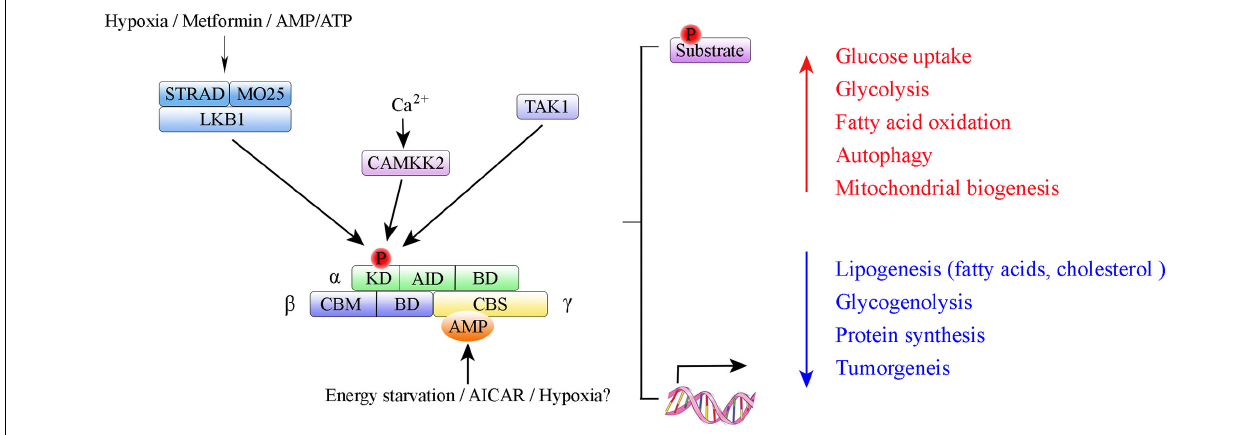
FIGURE 1 | Summary of AMP-activated protein kinase (AMPK) structure and activation. Domain structure of AMPK trimer: α -, β -, and γ -subunits with respective domains. AMPK α subunits: KD, kinase domain containing Thr-172 phosphorylation site; AID, autoinhibitory domain; BD, binding domain. AMPK β subunits: CBM, carbohydrate binding module; BD, binding domain. AMPK γ subunits: CBS, cystathione- β -synthase domain. The upstream kinases LKB1, CAMKK2, and TAK1 are shown above the AMPK complex. LKB1 in complex with STRAD and MO25 activates AMPK; CAMKK2 activated by intracellular